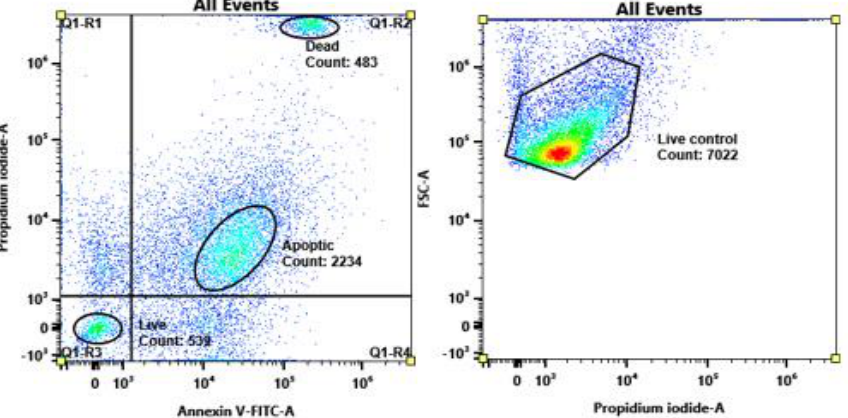
Figure 8. Control samples of dead, apoptotic (treated with camptothecin), and control cells of B16F1 murine melanoma cells.